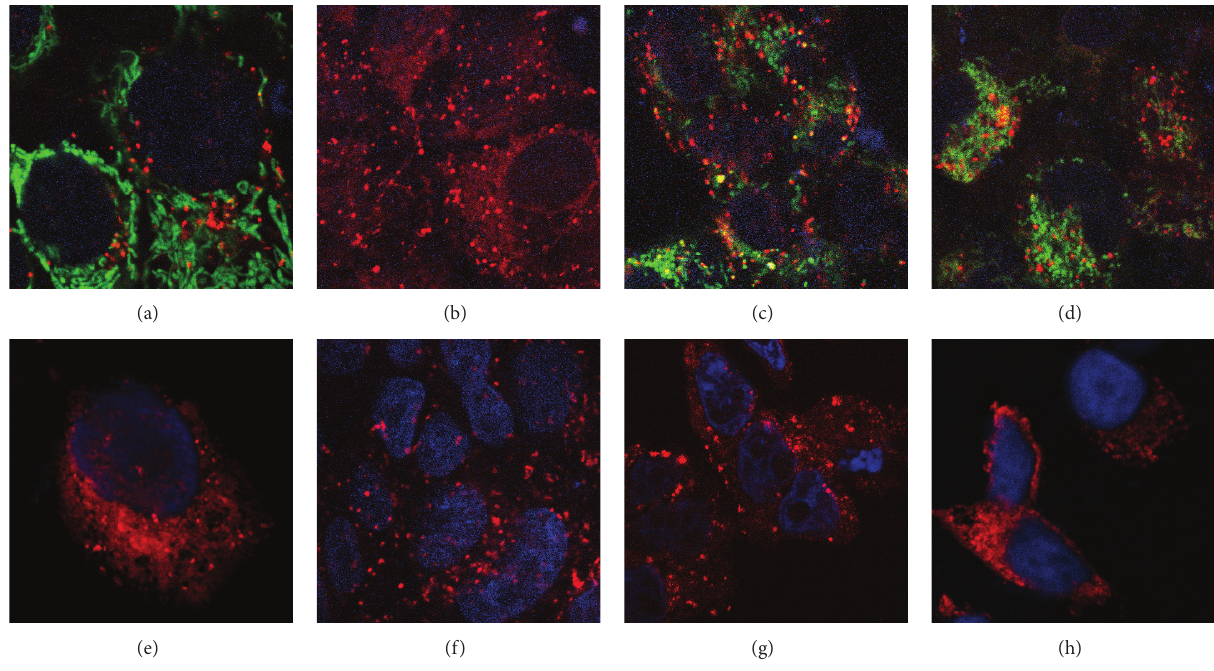
Figure 5: Images of the following cell lines: A431 ((a), (e)), MDCK ((b), (f)), HEK239 ((c), (g)), HBL-100 ((d), (h)) stained by the conjugate of histone H1.3 with PFD (“Histone H1-PFD”) for the “live” (images (a)–(d)) and fixed (images (e)–(h)) cells (image dimensions, 42 by 42 𝜇